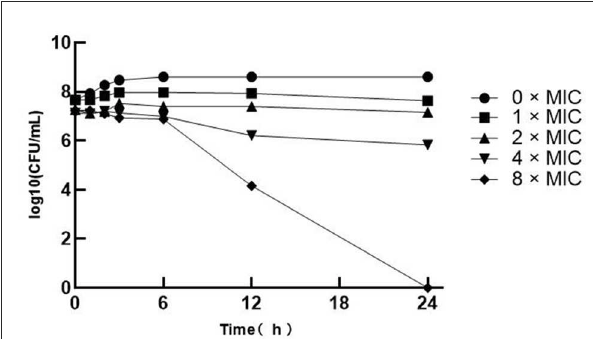
FIGURE1 The Bactericidal Activity Curve of SGCH against SA . The curve from top to bottom in the figure are 0 × MIC, 1 × MIC, 2 × MIC, 4 × MIC and 8 × MIC,